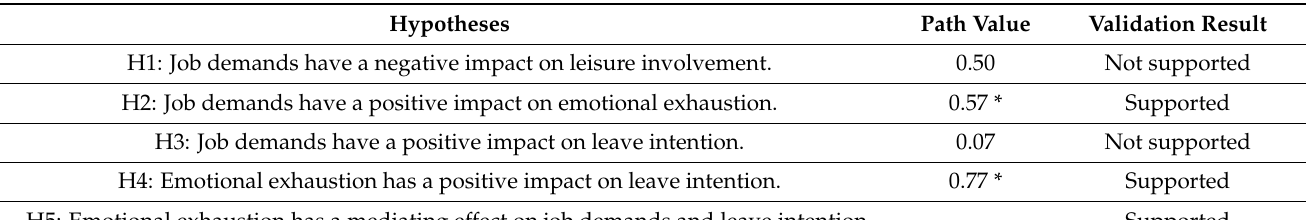
Table 10. Summary of hypotheses and validation